Question: Produce a descriptive caption suitable for publication.
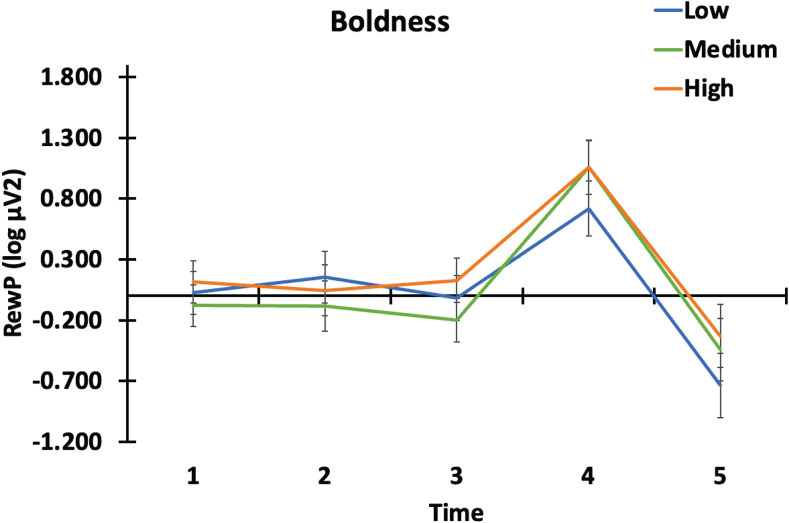
Answer: EEG power of boldness group on RewP . Note: The Y axis represents the EEG (log µV 2 ) for the measure of the GAS – reward positivity (RewP). The X axis presents the time points (ms): 1 = 0–70; 2 = 70–100; 3 = 100–200; 4 = 200–300; 5 = 300–400. Boldness groups are: low (blue); medium (green; and high (orange). Error bars represent standard error.